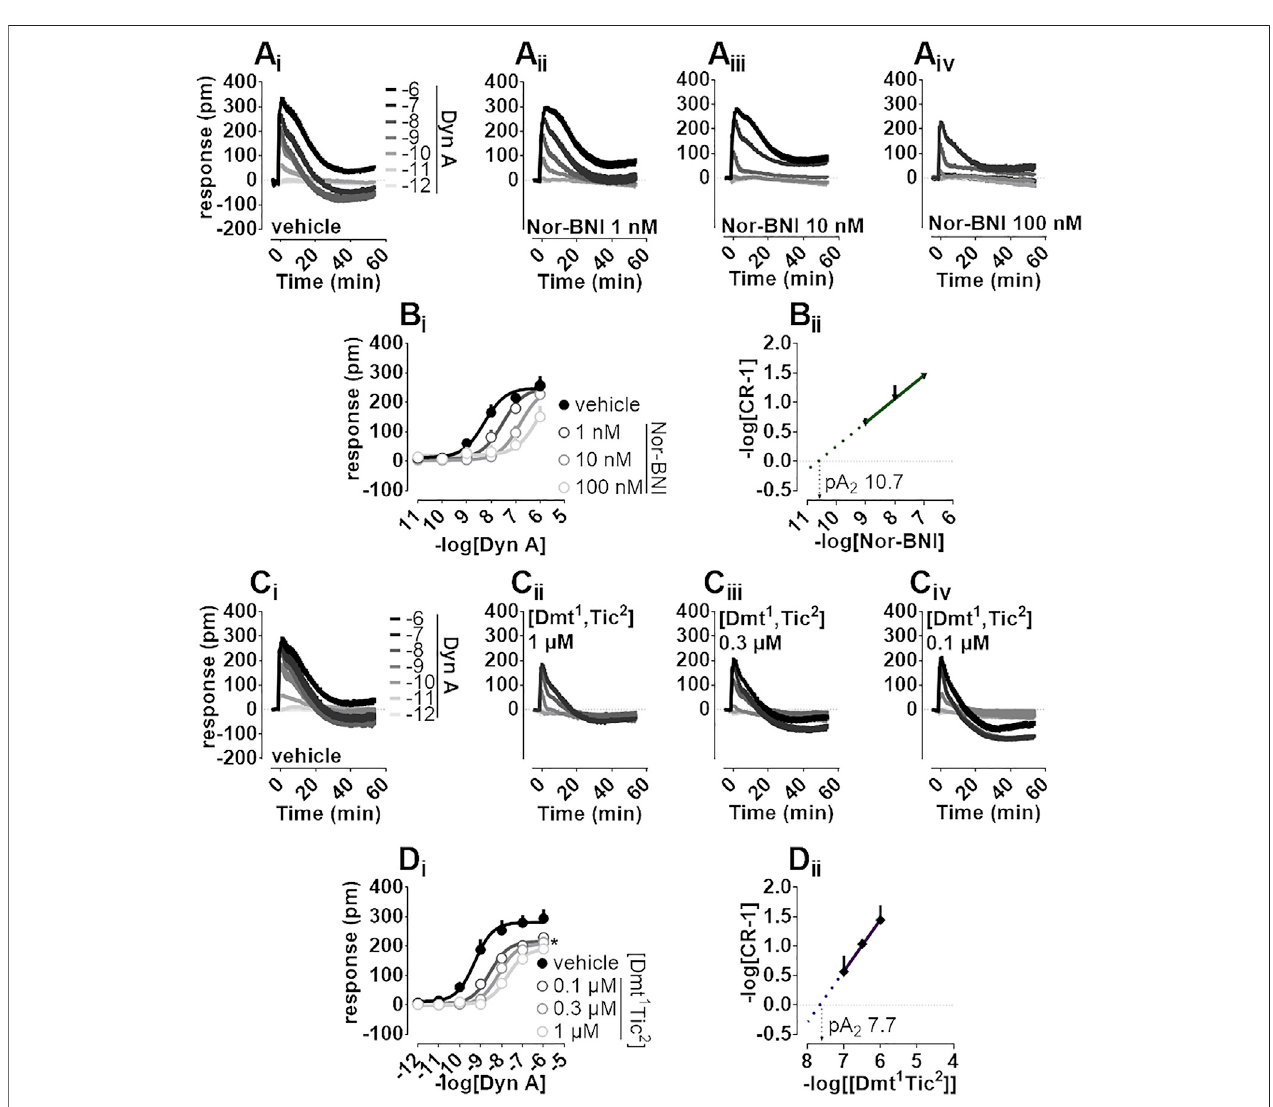
FIGURE 3 | DMR experiments in CHO cells stably expressing the human kappa opioid receptor (A i-iv ) Averaged kinetic traces of increasing (1 p.m. — 1 µM) concentrations of Dyn A in the absence and in the presence of different (1 – 100 nM) concentrations of Nor-BNI, corresponding (B i ) concentration-response curves and (B ii ) Schild analysis (C i-iv ) Averaged kinetic traces of increasing Dyn A concentrations in the absence and in the presence of different (0.1 – 1 µM) concentrations of [Dmt 1 ,Tic 2 ] with corresponding (D i ) concentration-response curves and (D ii ) Schild analysis. Data represented are mean +sem of fi ve to seven independent experiments performed in duplicate and Emax were analyzed statistically using one-way analysis of variance followed by Dunnett ’ s test for multiple comparisons. p values < 0.05 were considered statistically signi fi cant and labelled with * .